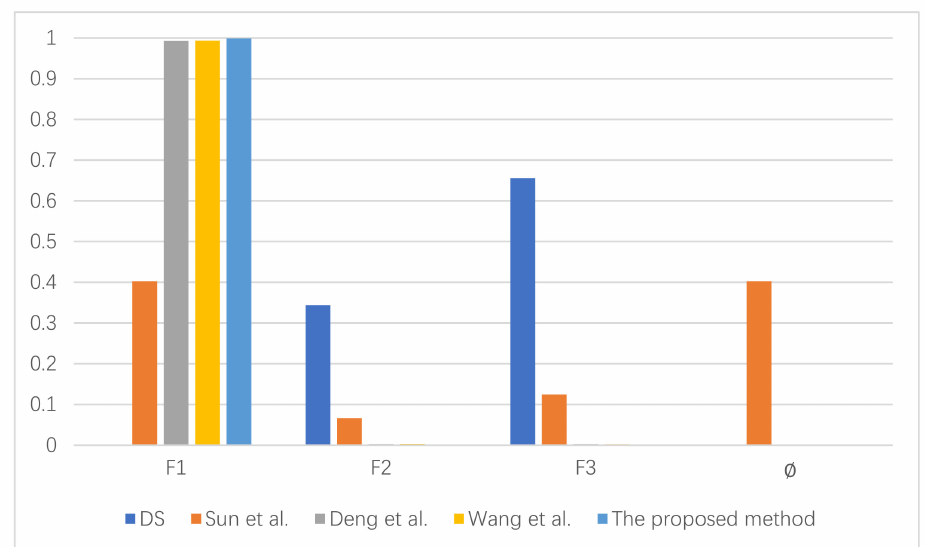
Figure 2. Fusion results of different methods in example.